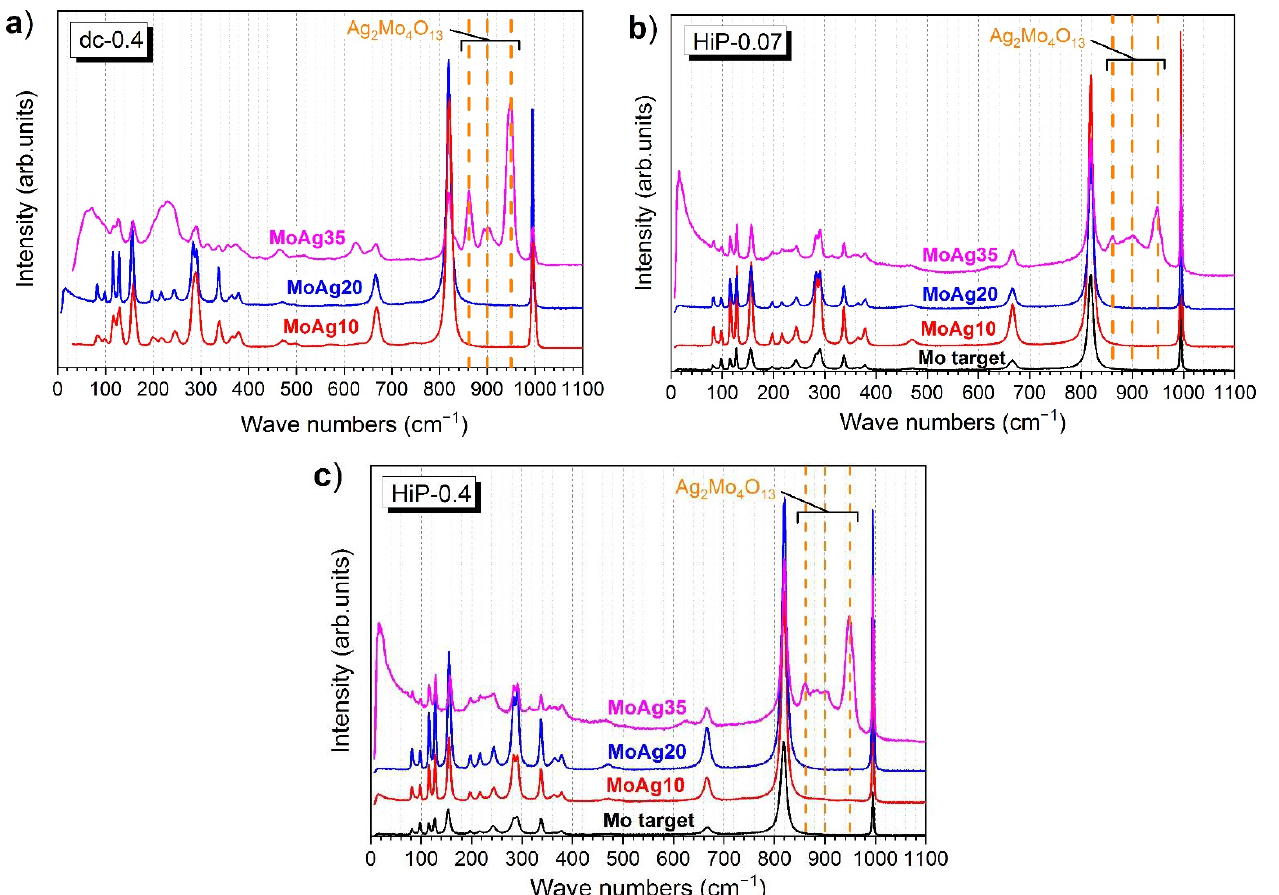
Figure 17. Macro Raman measurements. Spectra taken outside the wear track of samples after HT tribotests. The spectra in ( a ) are from series dc-0.4, in ( b ) from HiP-0.07 and in ( c ) from HiP-0.4.